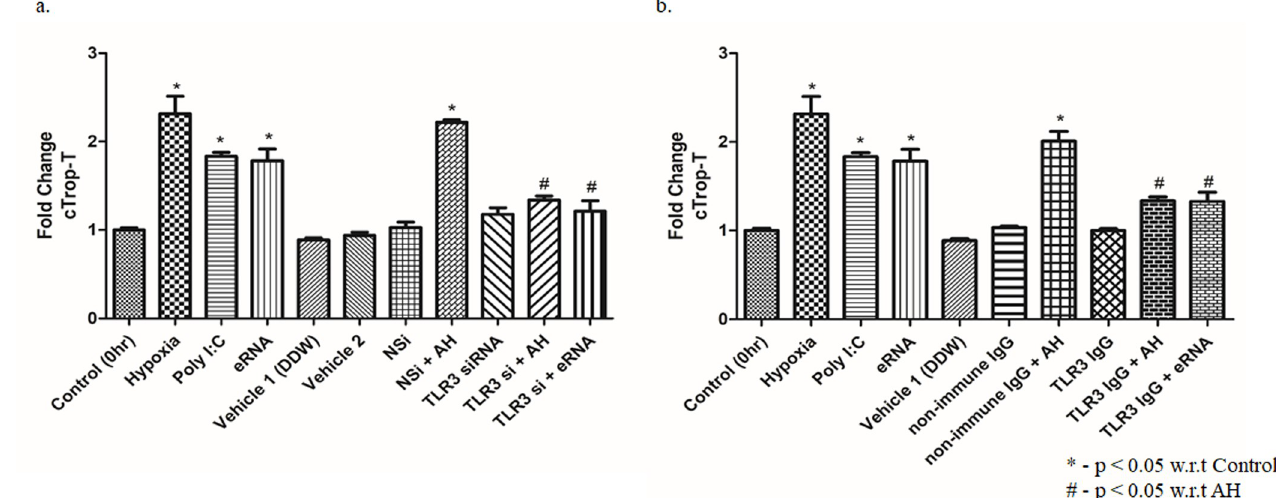
Fig 4. AH induced eRNA facilitates release of cTrop-T via TLR3 signalling. ELISA estimation of circulating cTrop-T in plasma was done after (a) TLR3 IgG treatment (40 mg/kg BW; 2 hrs prior to AH exposure). Poly I:C (1 mg/kg BW; 2 hrs prior to AH exposure) and eRNA (80 μ g/kg BW; 6 hrs prior to AH exposure) treatments were used as positive controls and (b) TLR3 siRNA treatment. Non-specific (NS) siRNA control and non-immune IgG control were used similarly in another group of mice. Data are shown as mean ± SEM (n = 5/group/treatment) from one experiment representative of three independent experiments, all performed in triplicate. One-way ANOVA revealed statistical significance in the results ( � p < 0.05 groups w.r.t control; #p < 0.05 groups w.r.t Hypoxia and eRNA).